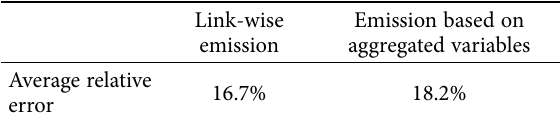
Table 1. Relative error results of Scenario 1 compared to the microscopic model